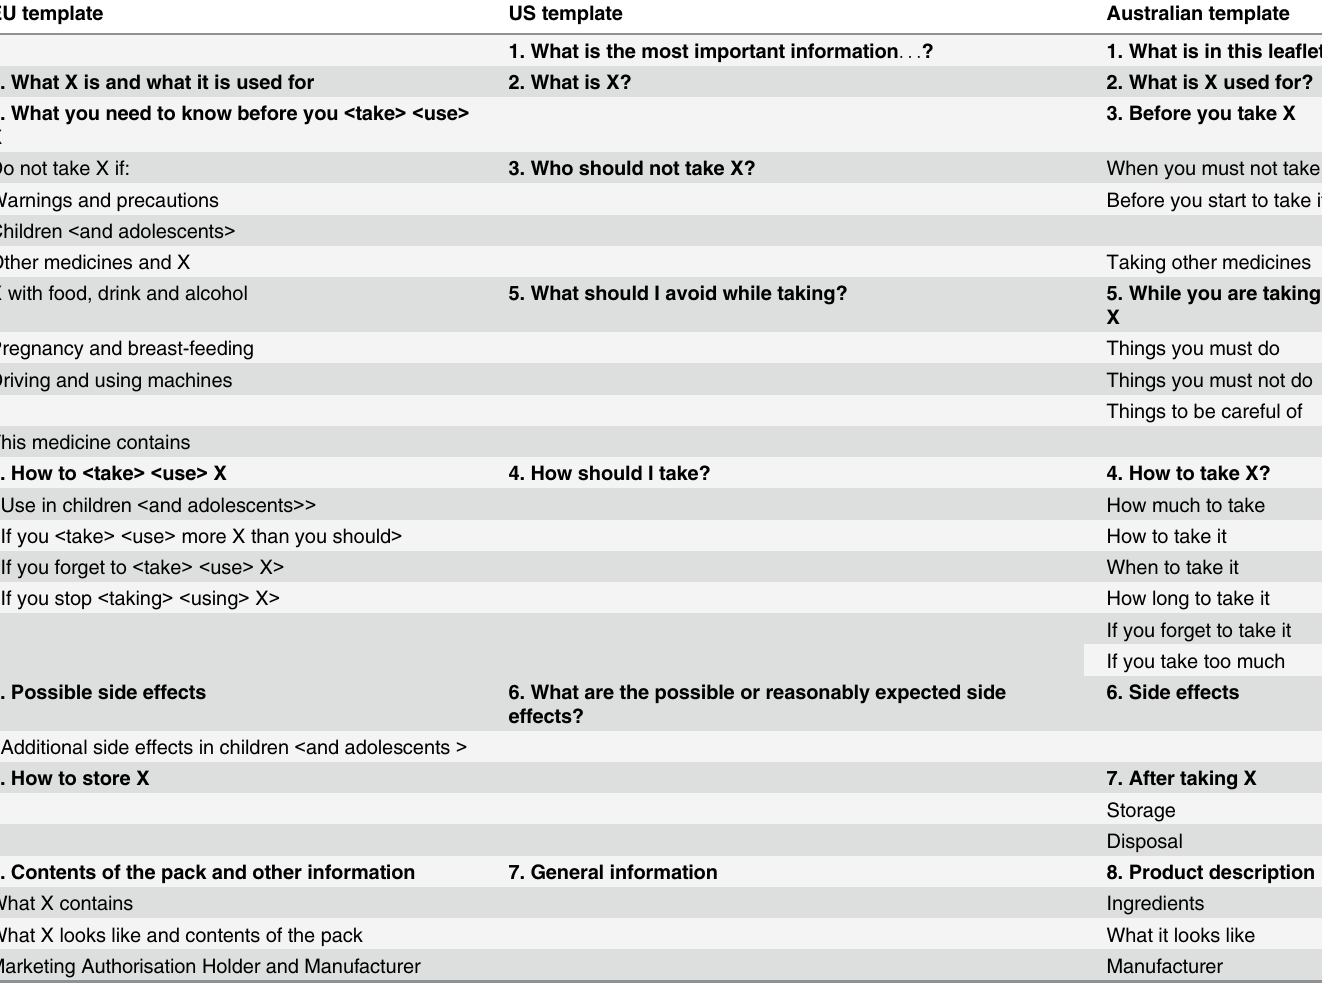
Table 1. The EU template for patient information about medicines compared with its US and Australian counterparts. US and AU templates have been reordered for comparison (but not renumbered). EU template US